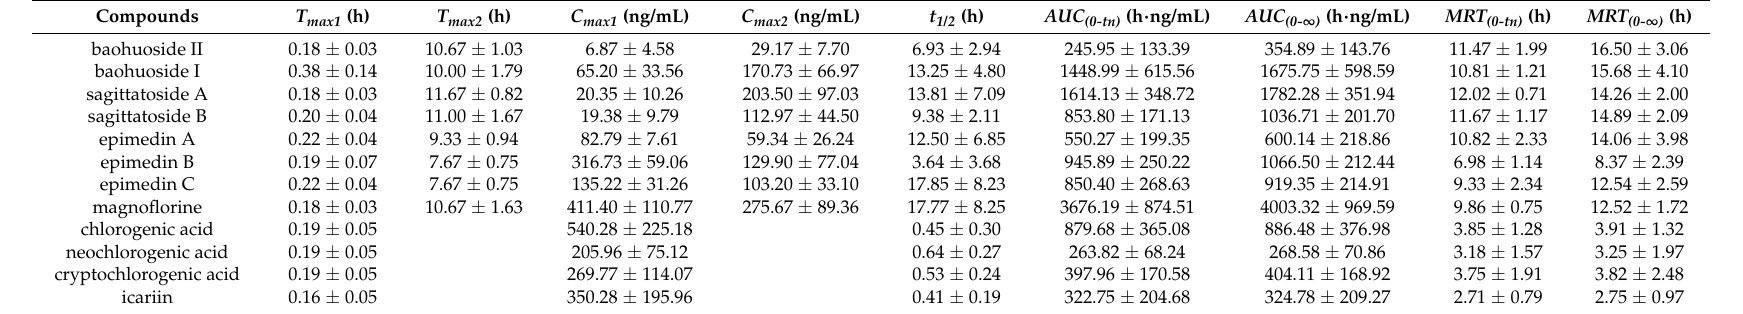
Table 5. Pharmacokinetic parameters of 12 analytes after oral administration of Epimedium extract ( n =